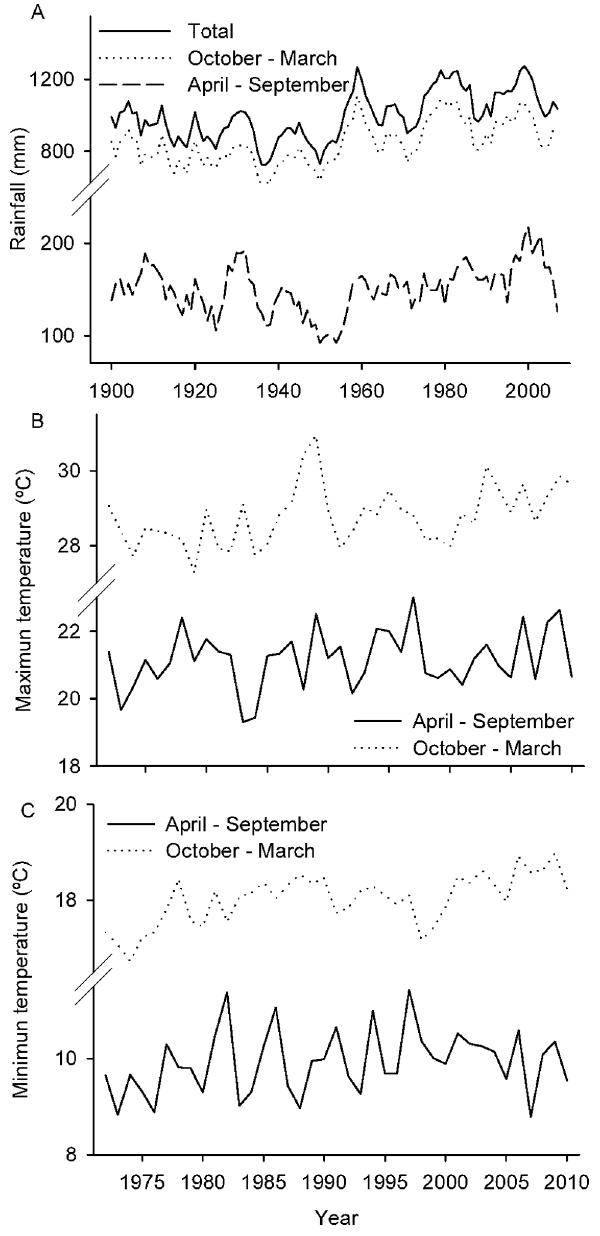
Figure 1. Rainfall and temperature records registered at Obispo Colombres Meteorological Station, Tucuma´n. a) Five year moving averages of annual rainfall (solid line), rainy season rainfall (October – March, dotted line) and dry season rainfall (April – September, dashed line) from 1900 to 2010; b) annual average of maximum and c) minimum temperatures during October – March (summer, dotted line), and April – September (winter, solid line) from 1972 to 2010. Rainfall and temperature data were registered at Obispo Colombres Meteorological Station, Tucuma´n (ca.500 m lower and 15 km east of the study